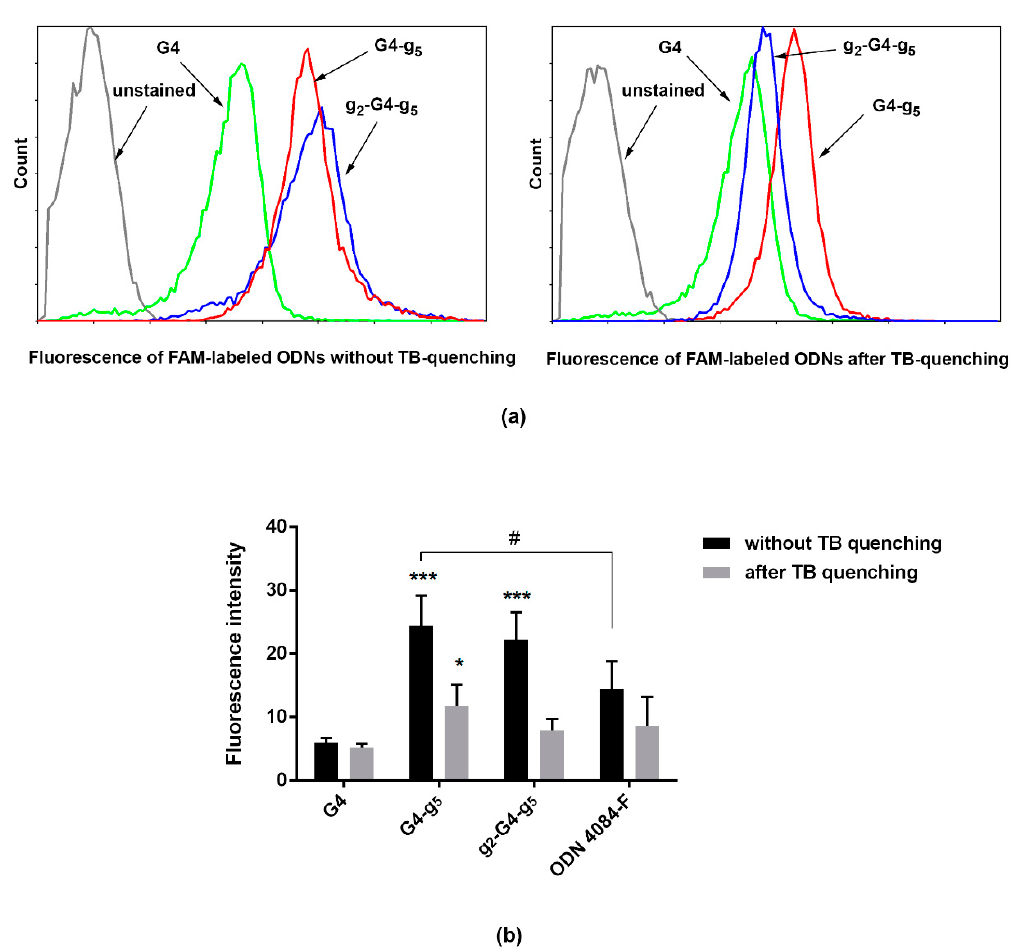
Figure 6. The presence of terminal phosphorothioate oligoguanosine runs at the ends of G-quadruplex core increases ODNs’ bioavailability. PMNLs (1 × 10 6 / mL) in HBSS / HEPES were incubated for 20 min at 37 ◦ C in 5% CO 2 without additives (control probe) or with 0.5 µ M 6-fluorescein amidite (FAM)-labeled ODNs. Oligonucleotide accumulation by cells was analyzed by flow cytometry. The surface fluorescence was quenched by TB solution. ( a ) Presented are exemplary histograms of cell fluorescence without (left) and after (right) treatment with TB. ( b ) Values represent the means ± SEM of FAM fluorescence intensities (arbitrary units) (n = 4). * p < 0.05; *** p < 0.005 compared to the corresponding values for FAM-labeled G4; # p < 0.05 for the pair of data specified, as indicated by two-way ANOVA followed by Tukey’s multiple comparison test. Fluorescence intensities of unstained control probes were 0.508 ± 0.124 and 0.357 ± 0.056 without or after TB quenching, respectively.